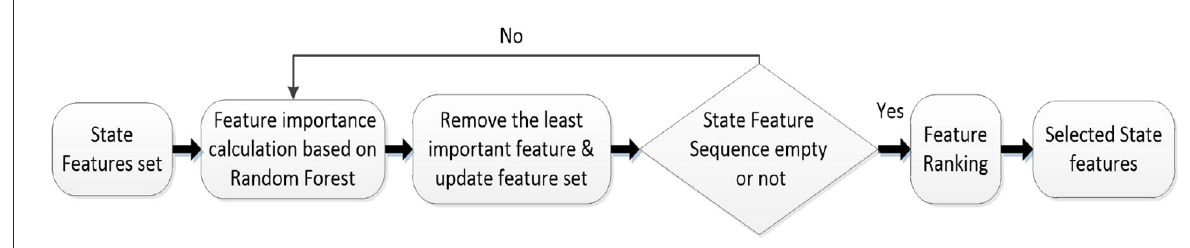
FIGURE5 Recursive feature elimination based on random forest (RF-RFE) algorithm flow.